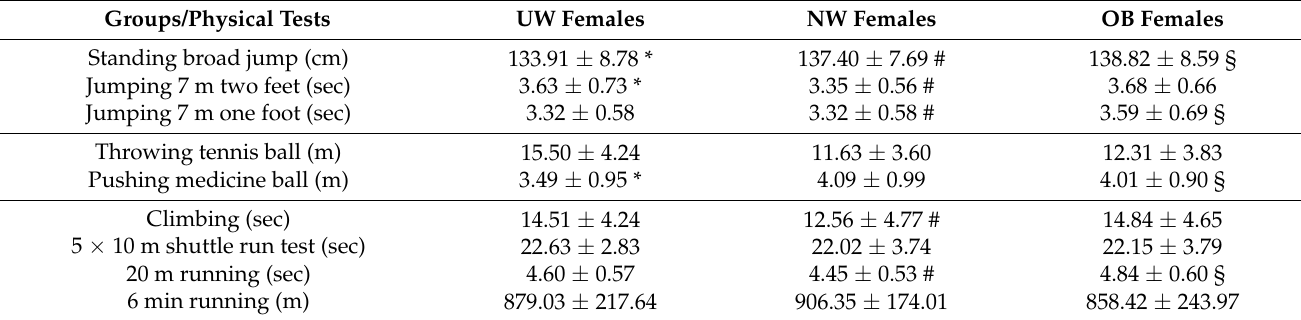
Table 3. Differences between groups of female participants in the physical fitness tests.